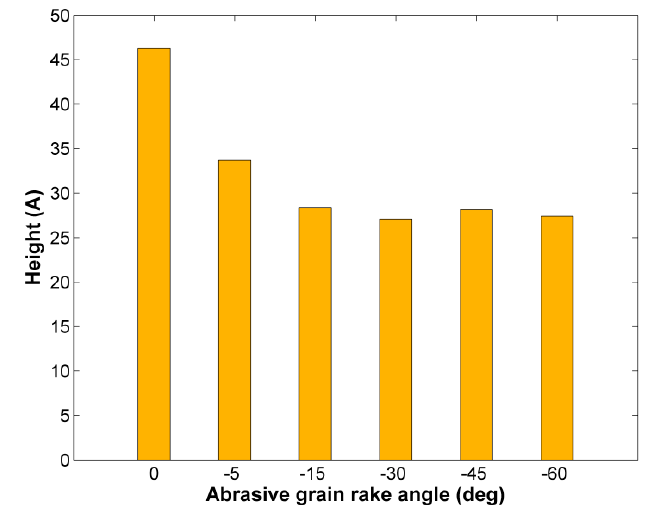
Figure 9. Chip height during nanogrinding in respect to abrasive grain rake angle.